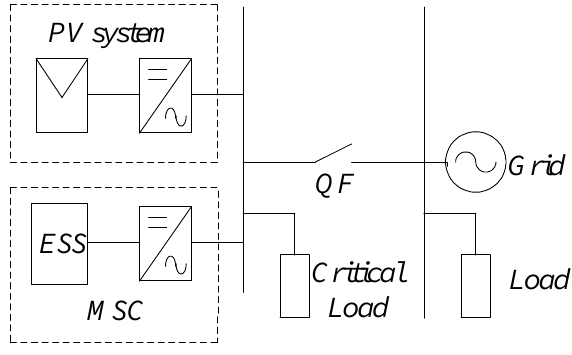
Figure 1. Microgrid including the proposed